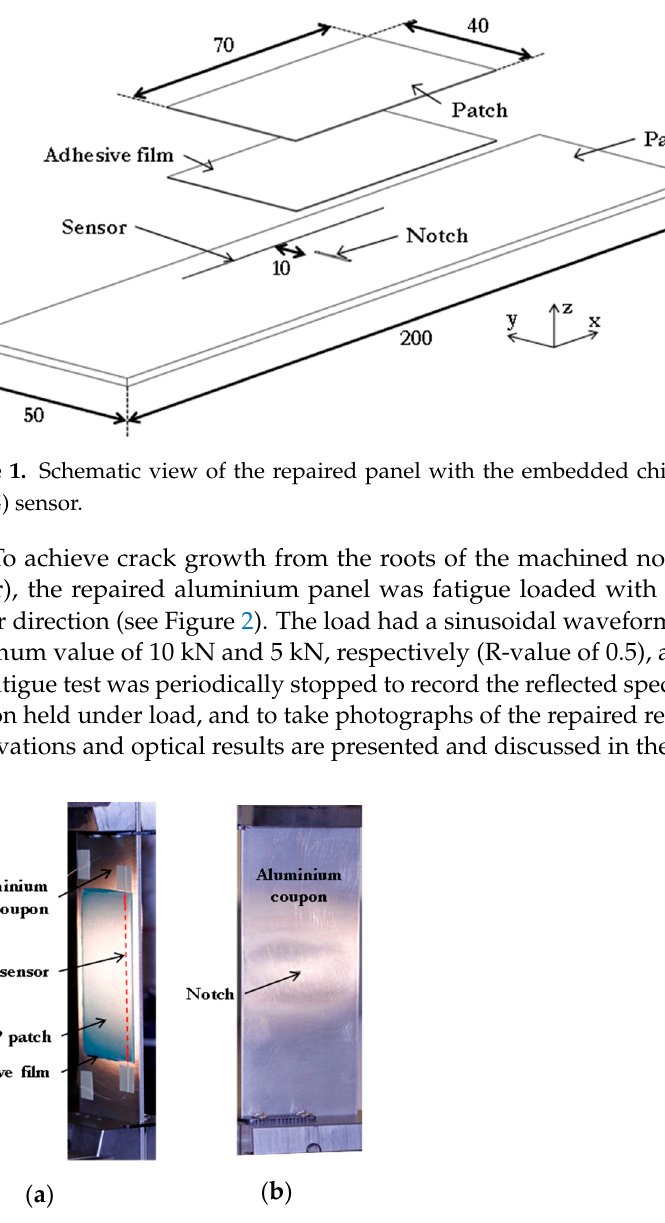
Figure 2. Photograph of the ( a ) patched and ( b ) unpatched faces of a repaired coupon subjected to tensile load.